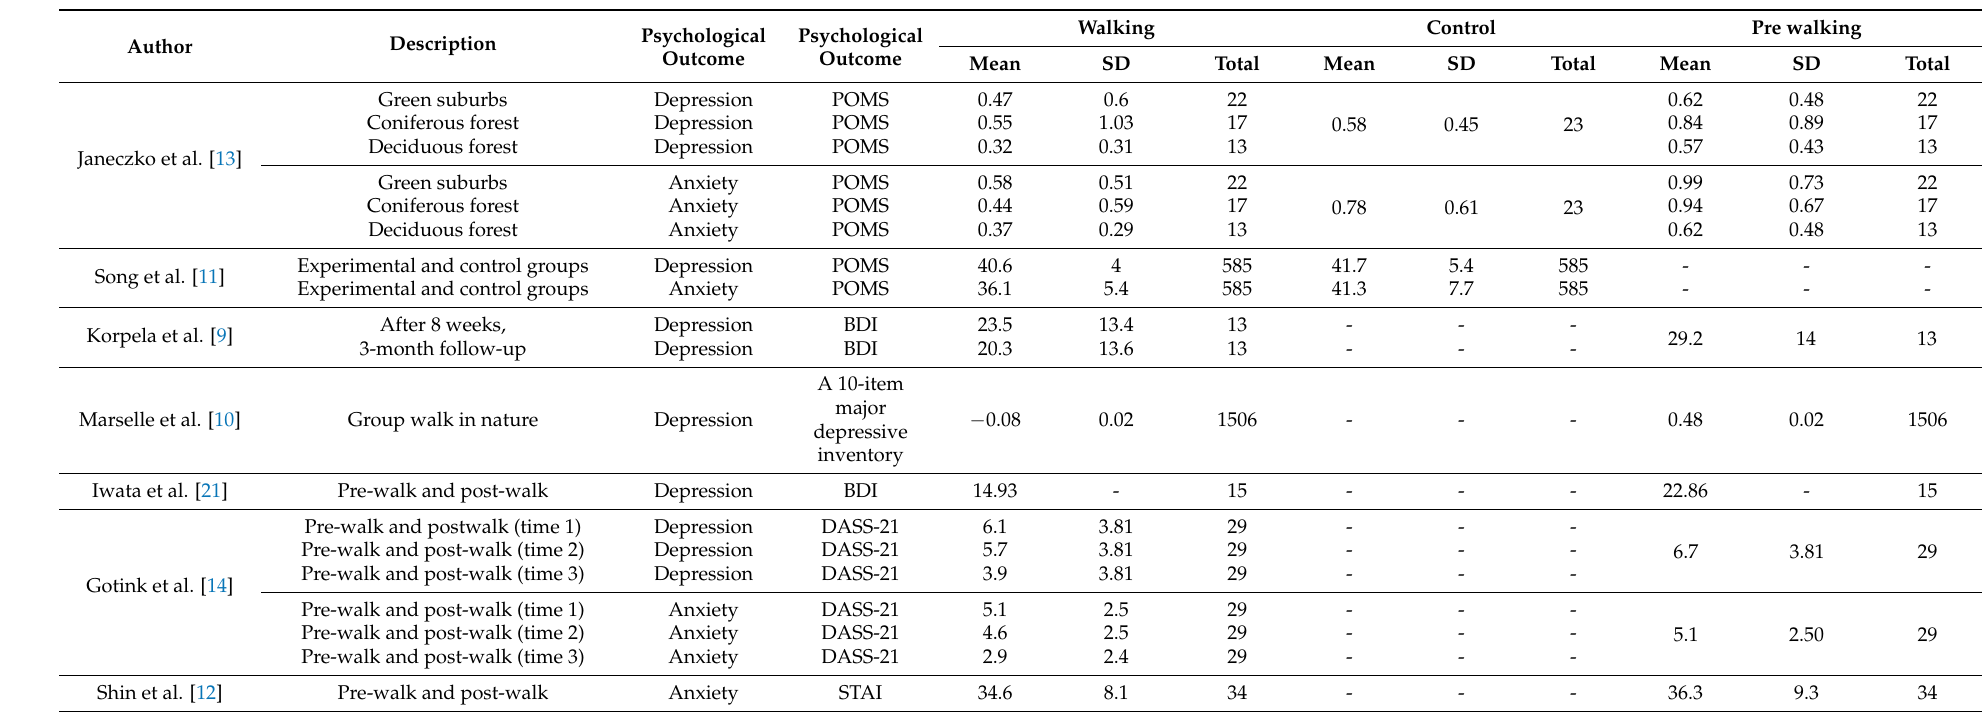
Table 3. Study characteristics (empirical findings of the